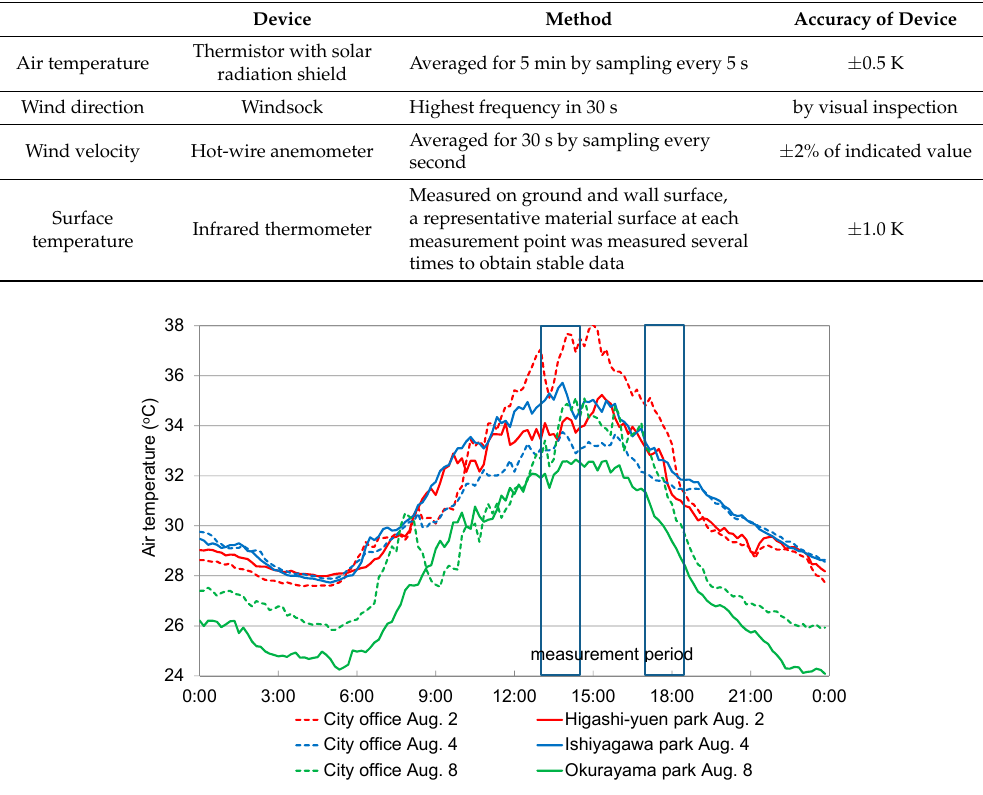
Figure 2. Measurement results of air temperature at the fixed measurement points.